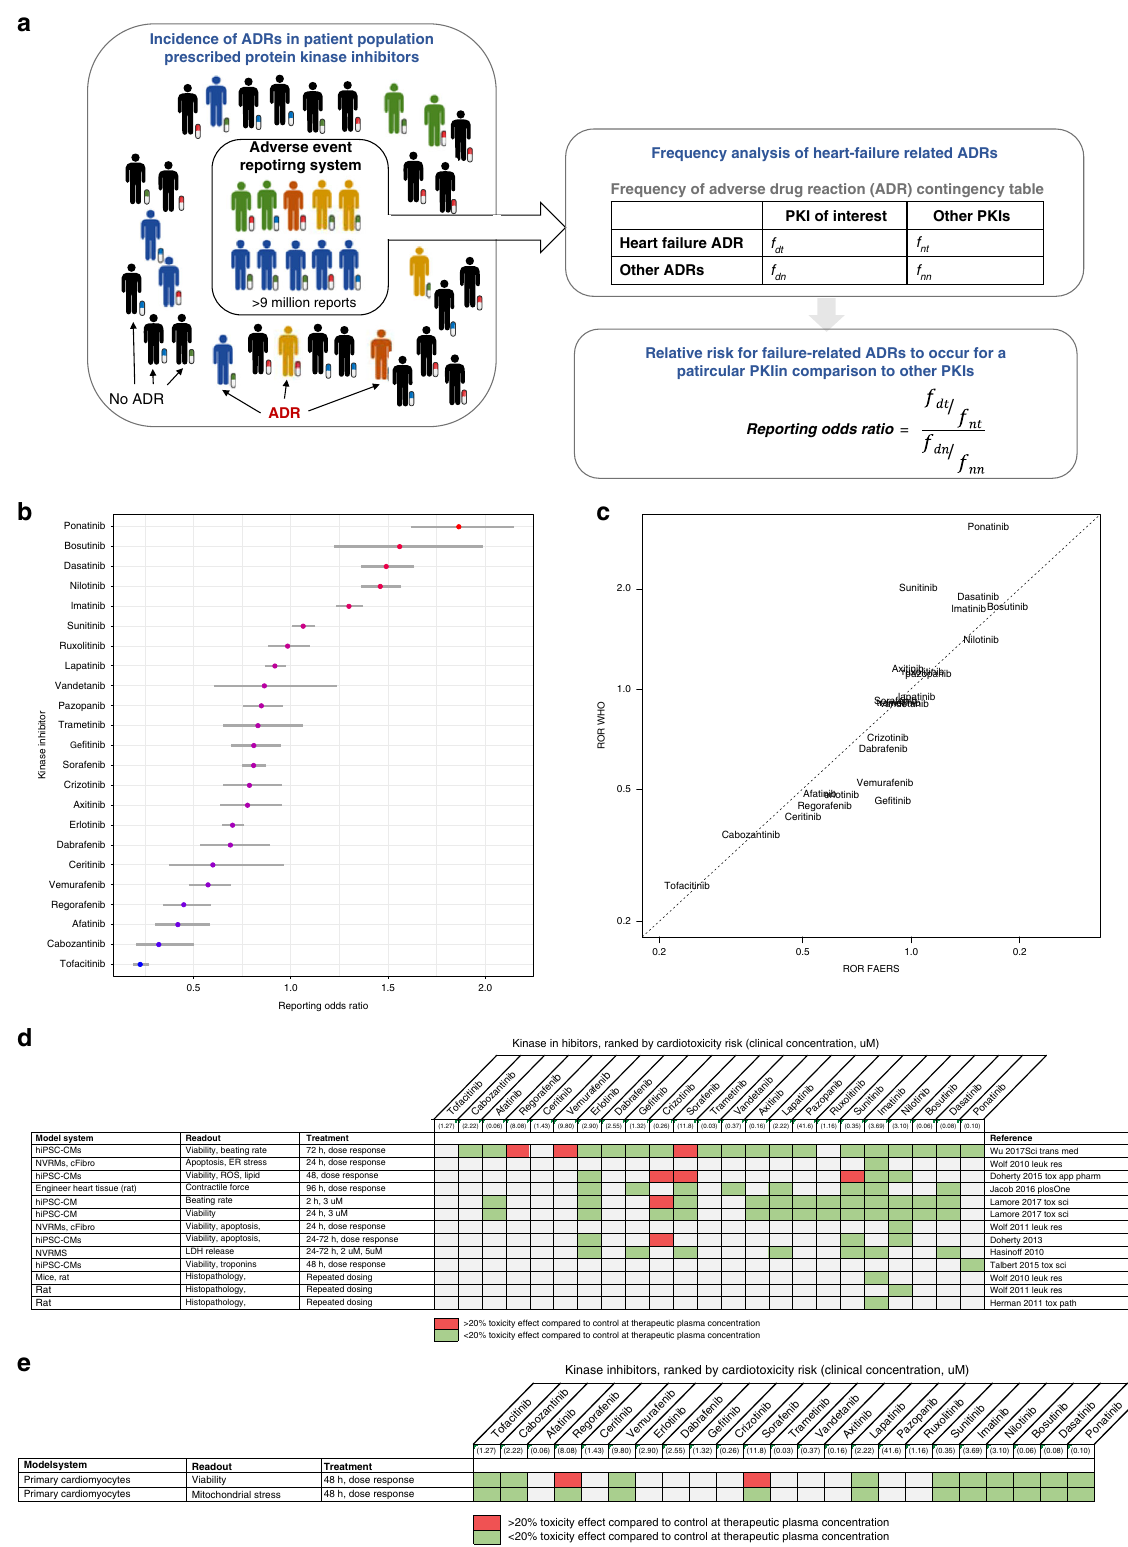
Fig. 1 Cardiotoxicity of protein kinase inhibitors. a Approach to quantify relative clinical cardiotoxicity risk scores for kinase inhibitors from the FDA Adverse Event Reporting System (FAERS) database. b Reporting odds ratio (mean and 95% con fi dence interval of computed odds ratio) for cardiotoxicity across kinase inhibitors from FAERS. c Comparison of ranking derived from FAERS and WHO Pharmacovigilance data shows agreement. d Literature- reported in vitro and in vivo preclinical assays to predict KI-associated cardiotoxicity poorly correlated with clinical FAERS-derived risk scores for cardiotoxicity at clinical drug concentrations. e In vitro dose – response experiments for selected KIs for viability and mitochondrial stress poorly correlate with clinical FAERS-derived risk scores for cardiotoxicity. Source data are provided in source data fi